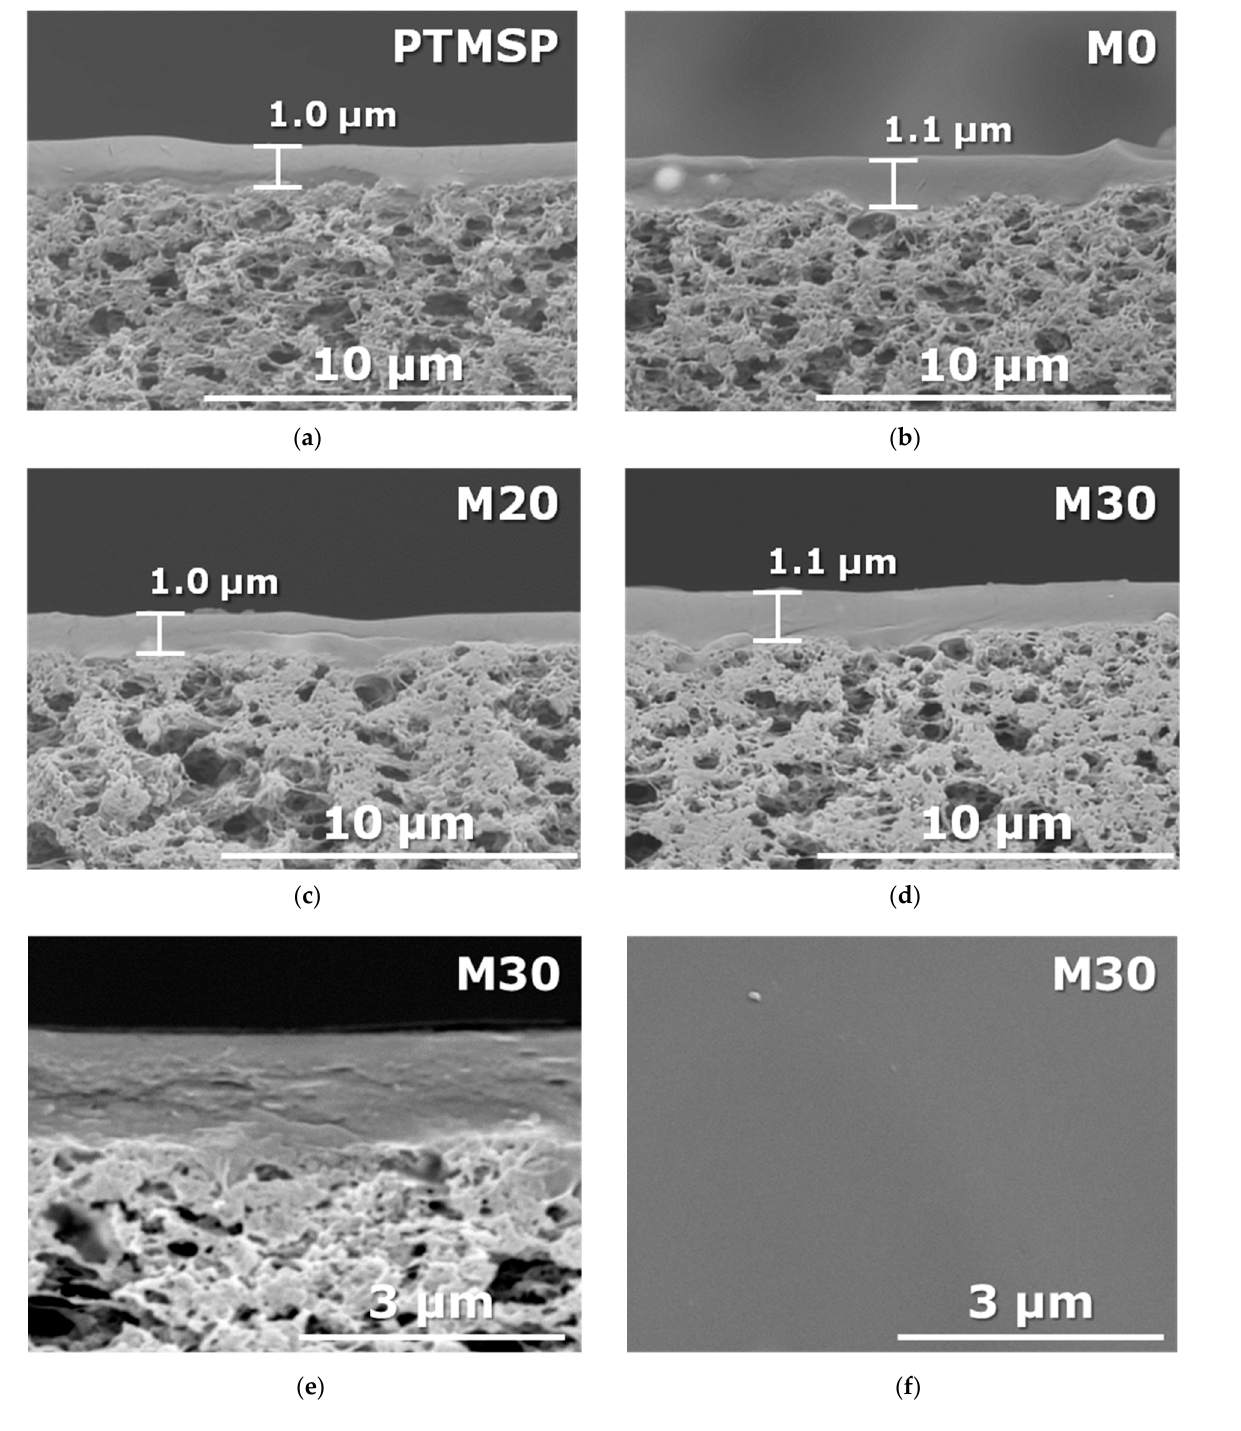
Figure 2. SEM images of the cross-section of TFC membranes: ( a ) neat PTMSP, ( b ) M0, ( c ) M20, ( d , e ) M30; and surface of M30 ( f ).